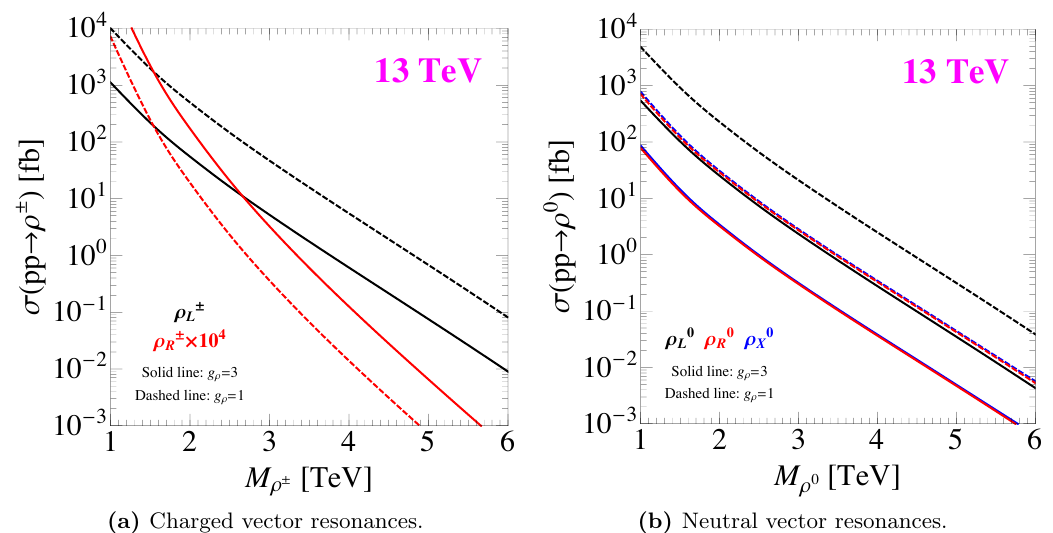
Figure 1. The Drell-Yan cross sections for the vector resonances at the 13 TeV LHC, in the unit of fb. The cross section of (cid:26) (cid:6) is shown as (cid:27) ( pp ! (cid:26) (cid:6) ) (cid:2) 10 4 . We have (cid:12)xed the parameters a 2 R R (see eq. (B.14), eq. (B.25) and eq. (B.32) for the de(cid:12)nitions) equal to 1 = 2. The rates are